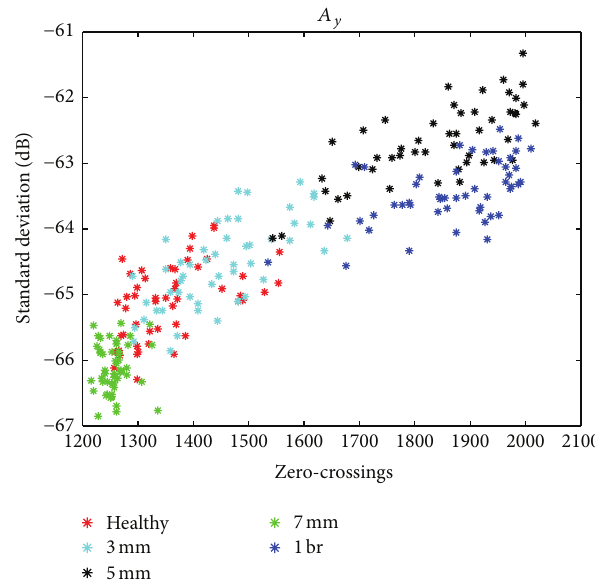
Figure 8: Unload condition analysis, 𝐴 𝑦 -axis.